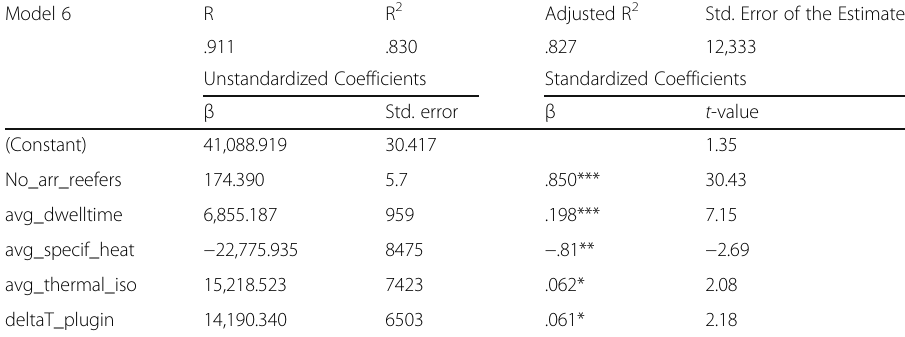
Table 7 Outcomes backward sequential regression